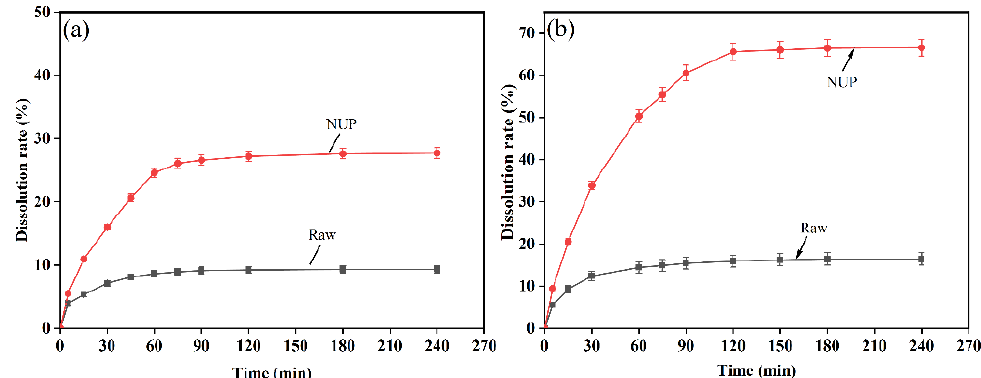
Figure 8. Cumulative release of the naringenin simples in ( a ) the simulated gastric fluid and ( b ) the